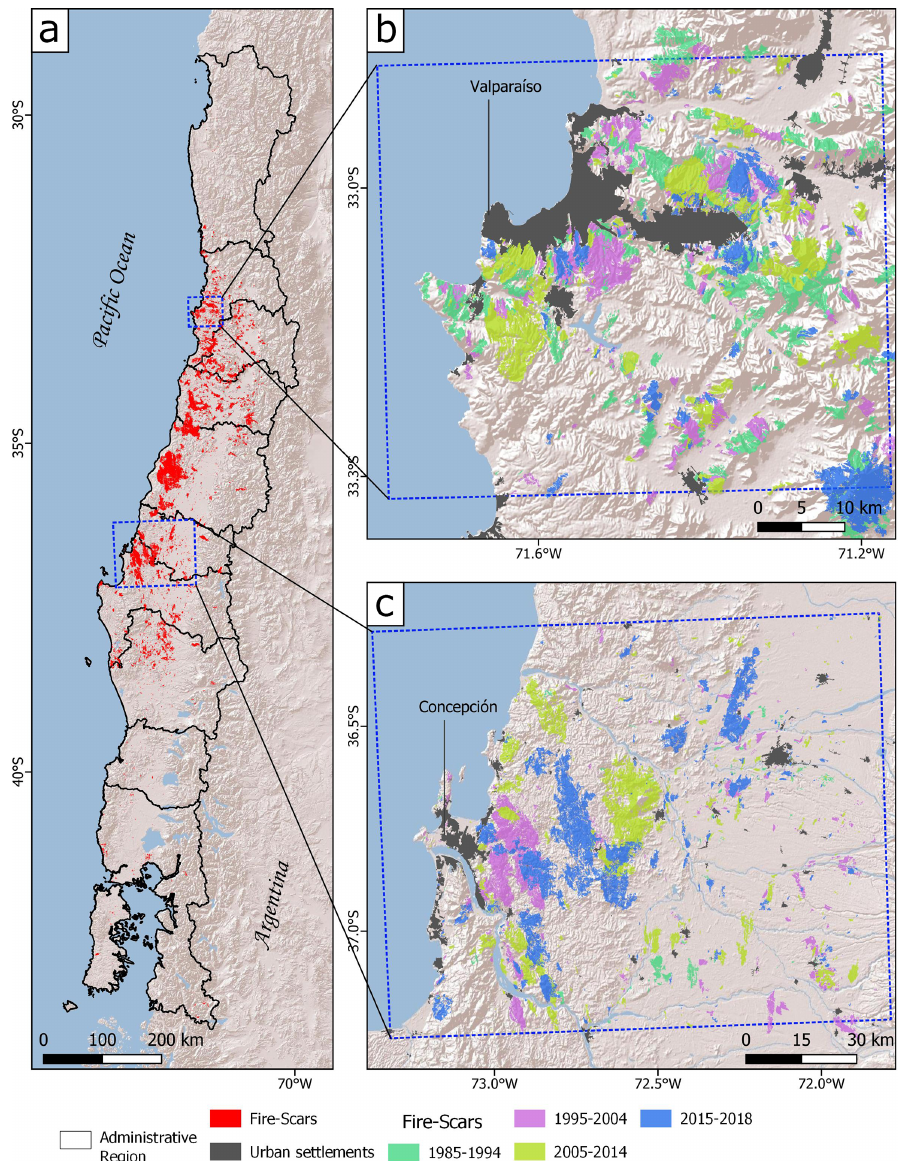
Figure 2. Panel (a) shows the geographic distribution of the fire scar database, and panels (b) and (c) show examples of fire activity near the cities of Valparaíso and Concepción for different